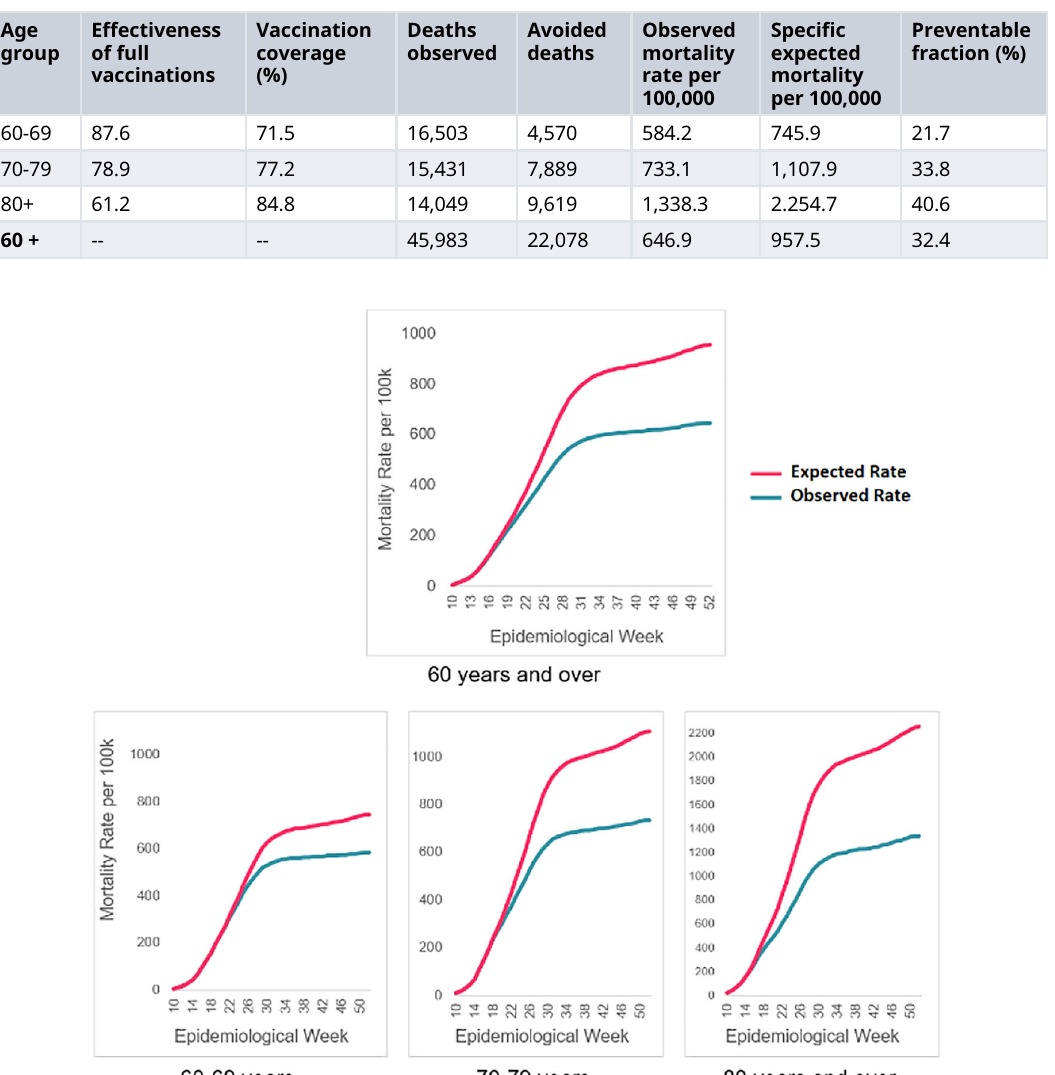
Table 1. COVID-19 avoided deaths by being fully vaccinated for adults 60 years of age and older. Colombia. Epidemiological weeks 10 to 52 of 2021.